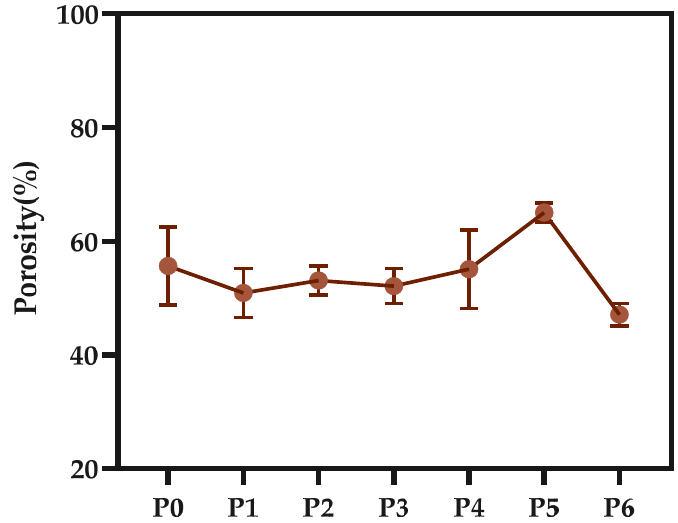
Figure 11. Porosity of various PA66